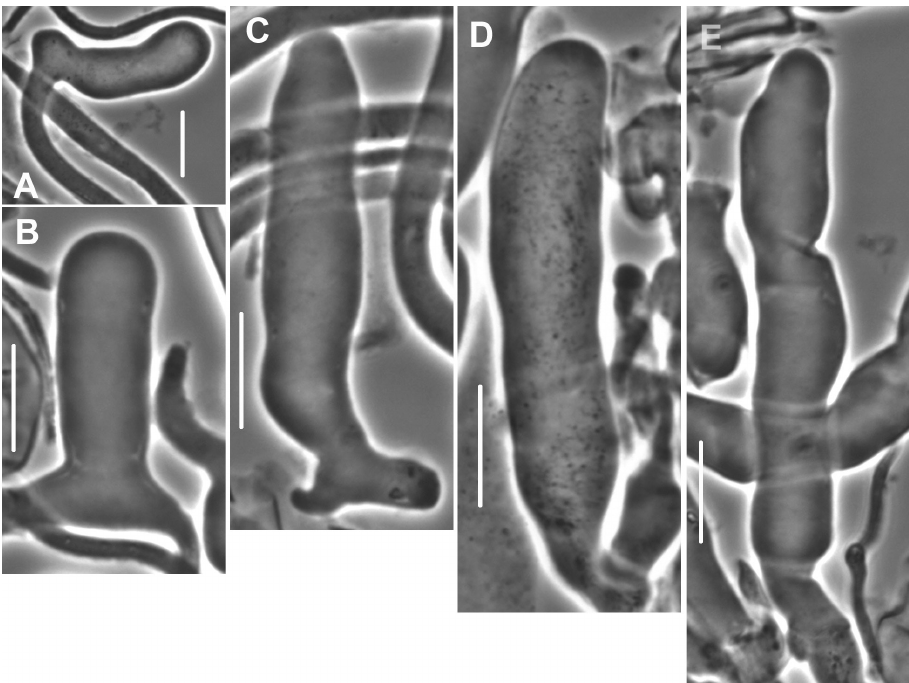
Figure 18. Mycetinis applanatipes . Caulocystidia from stipe apex. A Caulocystidium as hyphal terminus B Caulocystidium as side branch C–E Individual caulocystidia. Standard bars = 10 µm. DED 6628 (SFSU-F-